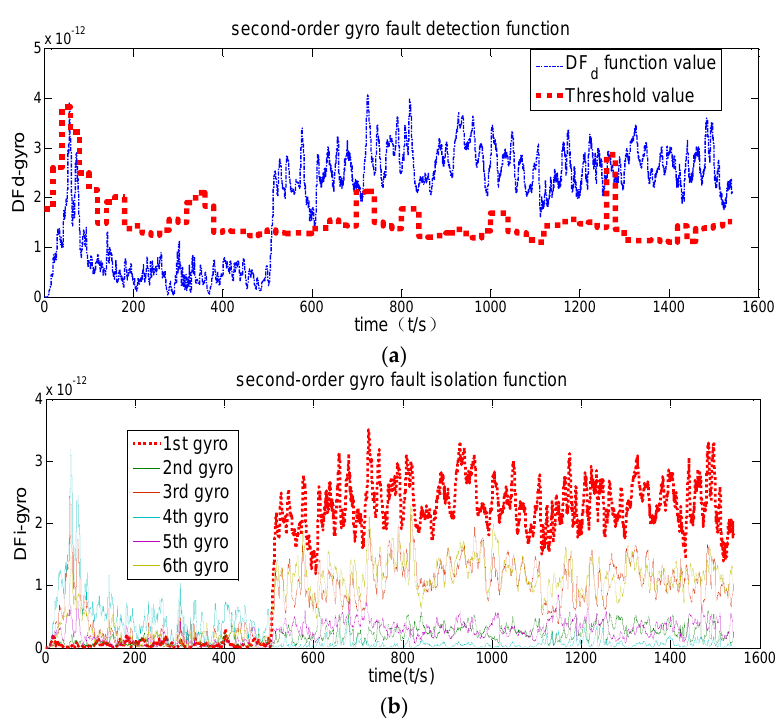
Figure 10. Second ‐ order channel filter (the fault amplitude is 0.5 / h  ). ( a ) Fault detection; ( b ) Fault Figure 10. Second-order channel filter (the fault amplitude is 0.5 ◦ /h). ( a ) Fault detection; ( b ) isolation. Fault